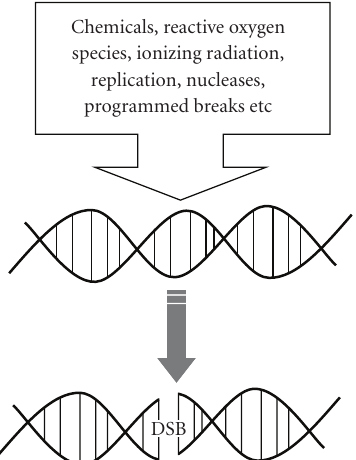
Figure 1: DNA damage caused by di ff erent genotoxic agents . The figure shows the formation of double strand breaks (DSBs) in dsDNA when exposed to DNA damaging agents like genotoxic chemicals, ionizing radiation as well as errors in the replication, programmed and unprogrammed action of